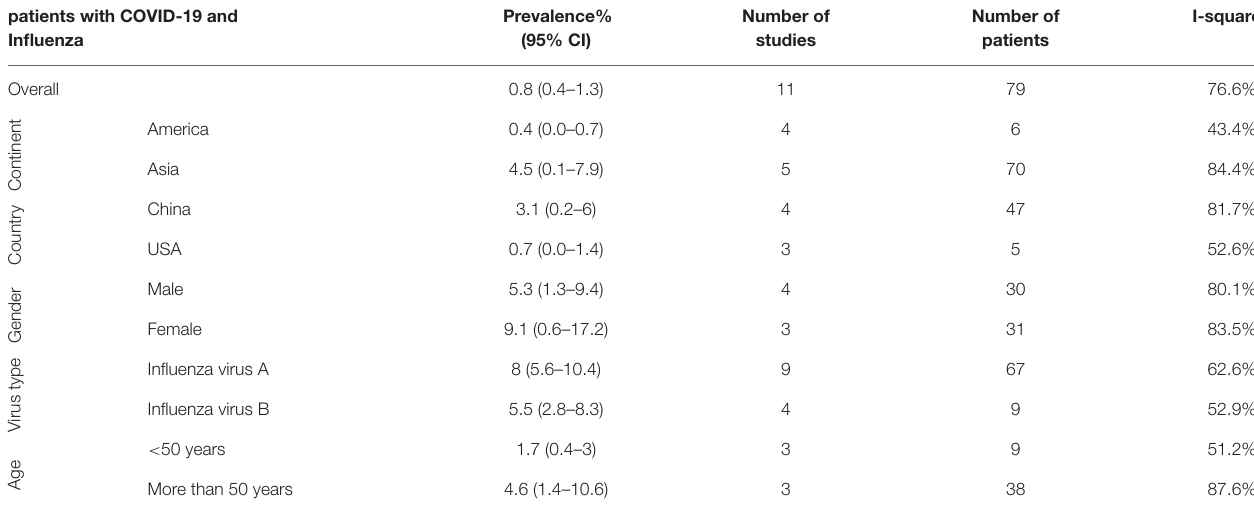
TABLE 3 | Frequency of Influenza co-infection among patients with COVID-19 based on different subgroups. patients with COVID-19 and